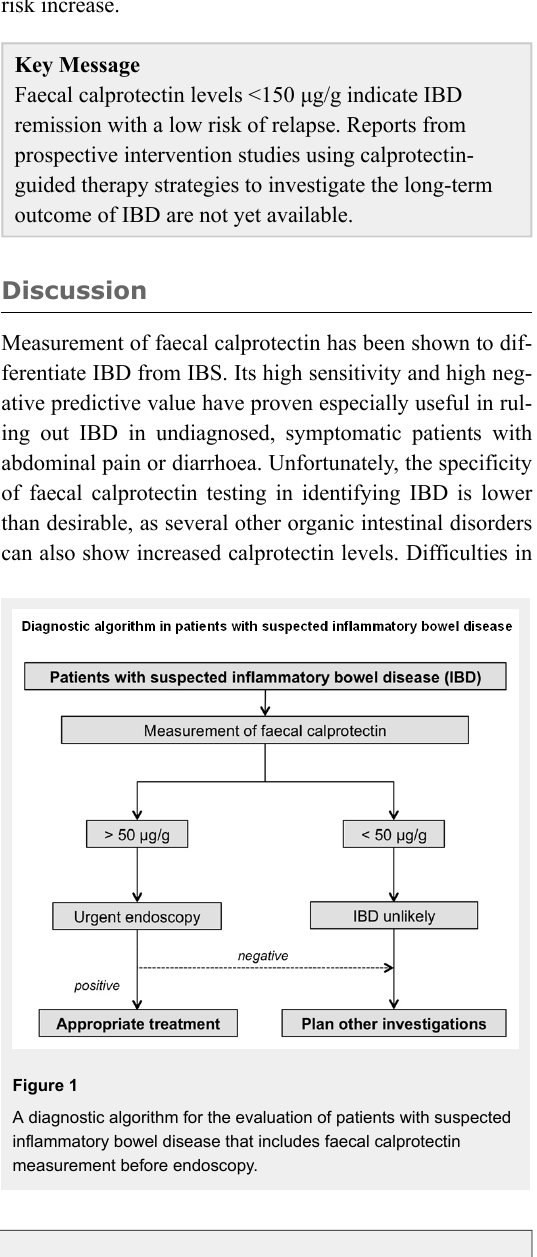
Table 4: Studies investigating the use of faecal calprotectin to predict relapse of IBD activity.